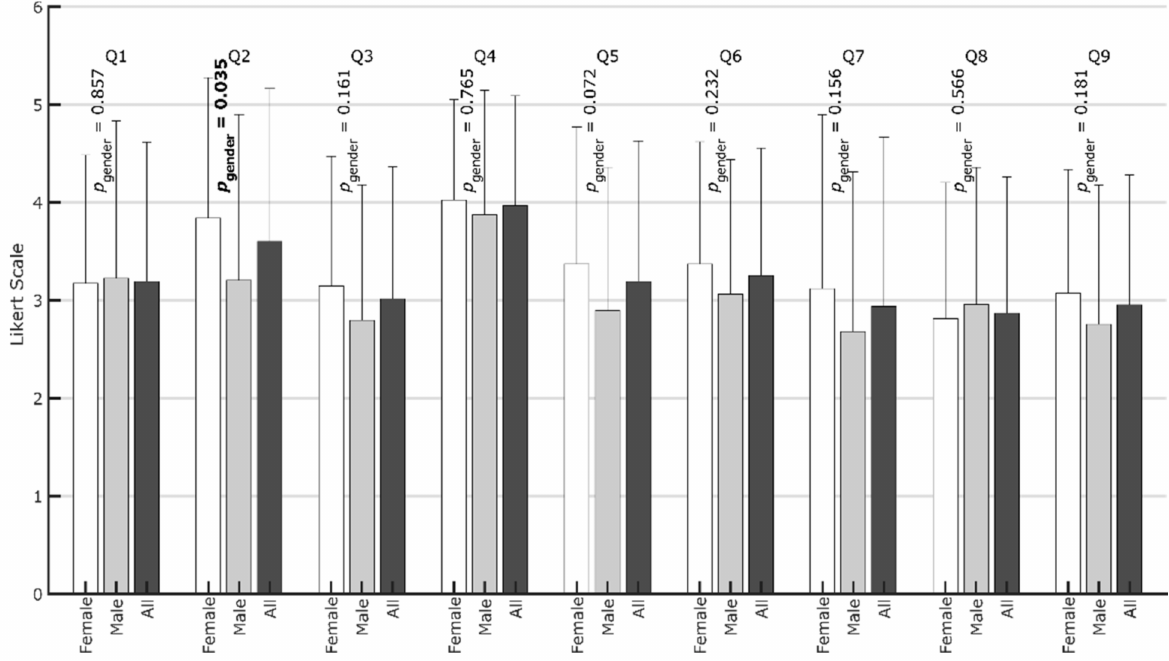
Figure 6. Diagram with means and standard deviations for the respective questions (Q1–Q9). The p -values for the tests of differences between genders are plotted vertically. Bold font indicates a statistically significant ( p < 0.05) difference in the response between female and male